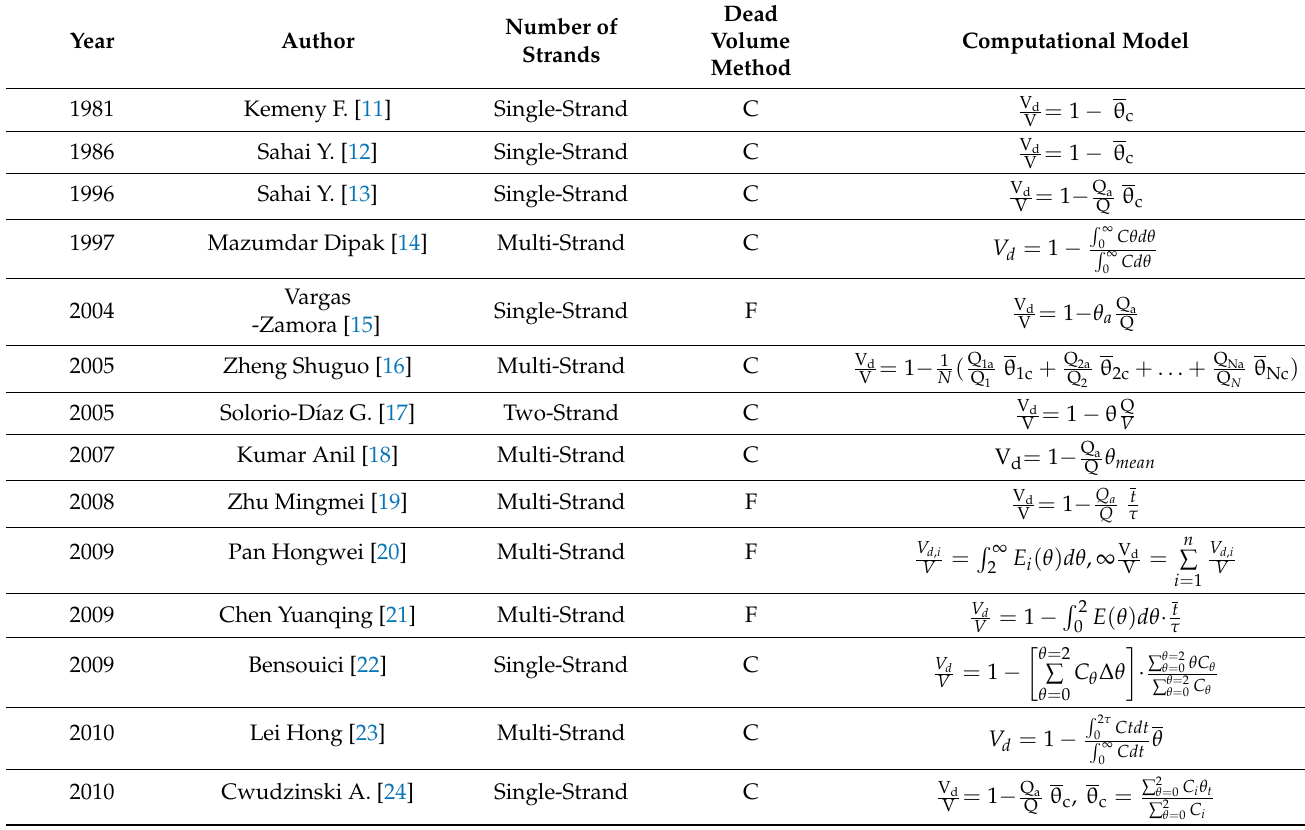
Table 1. The dead volume method for continuous casting